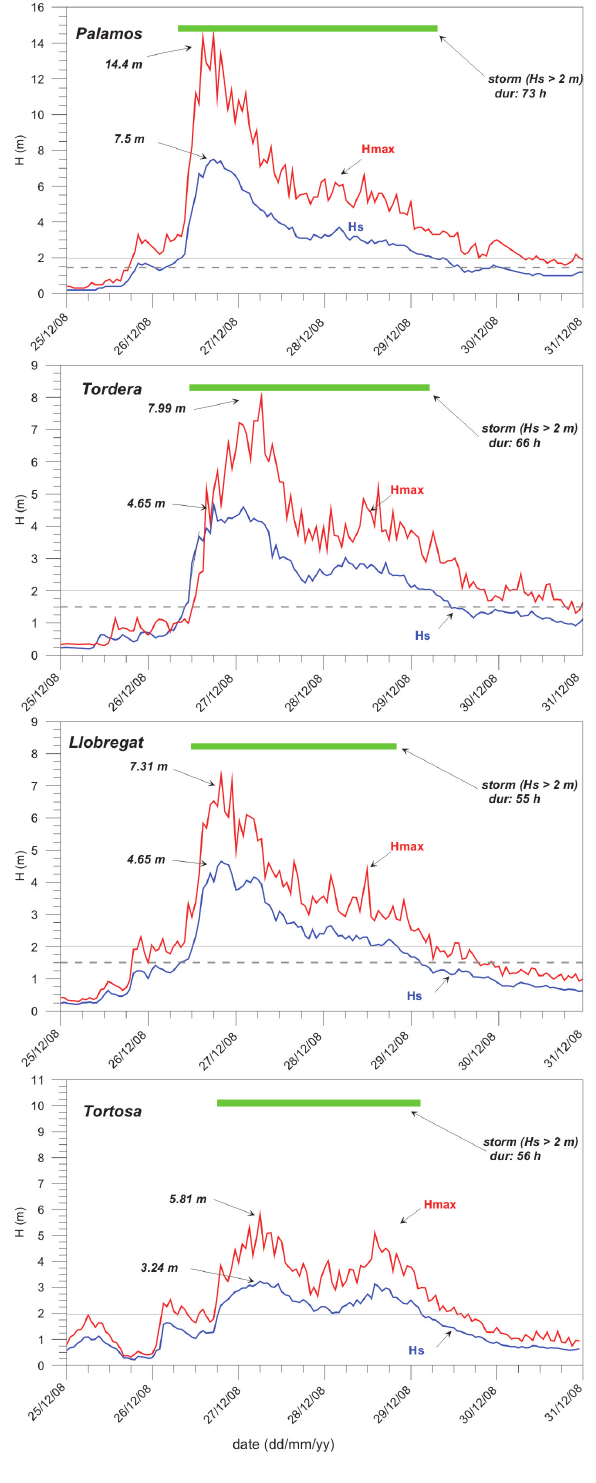
Fig. 2. Spatial variability along the Catalan coast during a storm in December